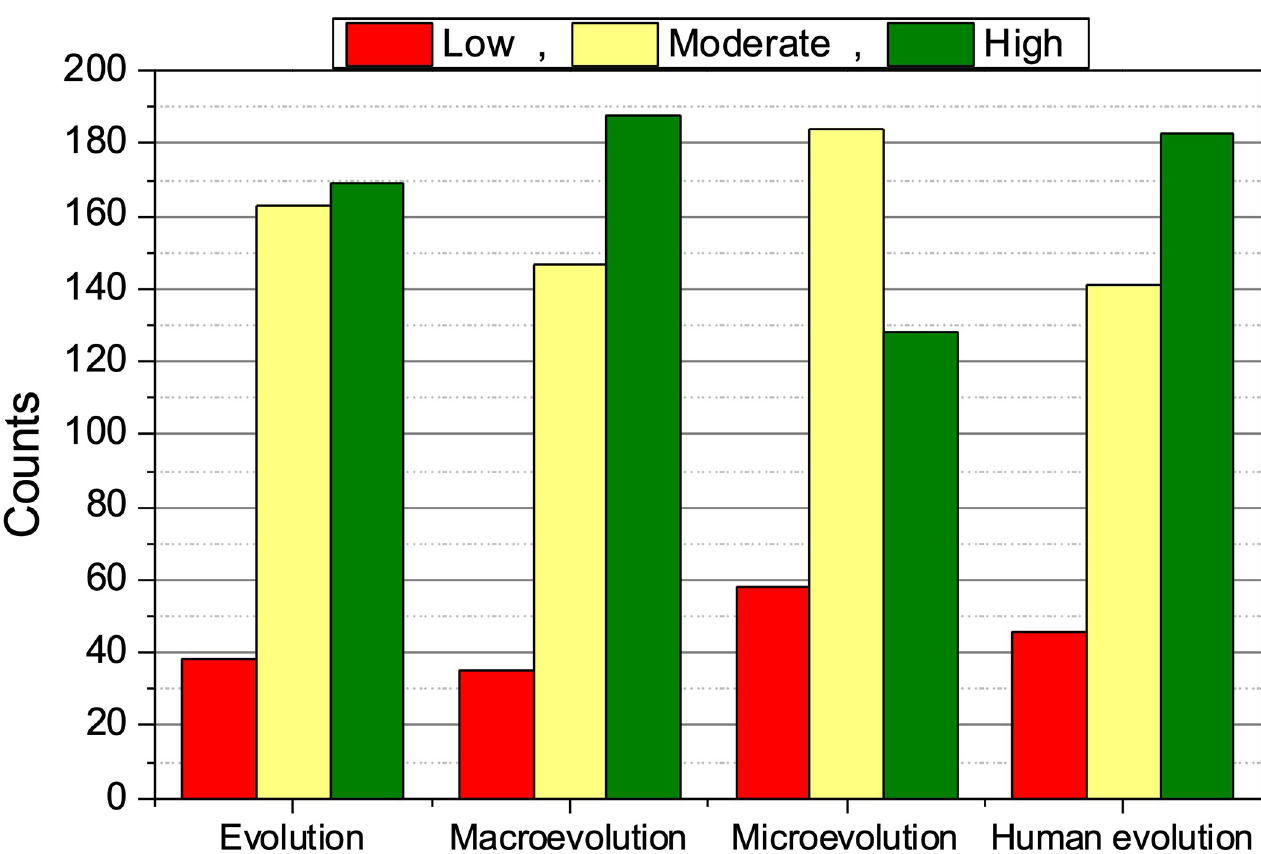
Fig 4. Evolution acceptance by sublevels. The values of the subscales were obtained through an analysis of proportions.